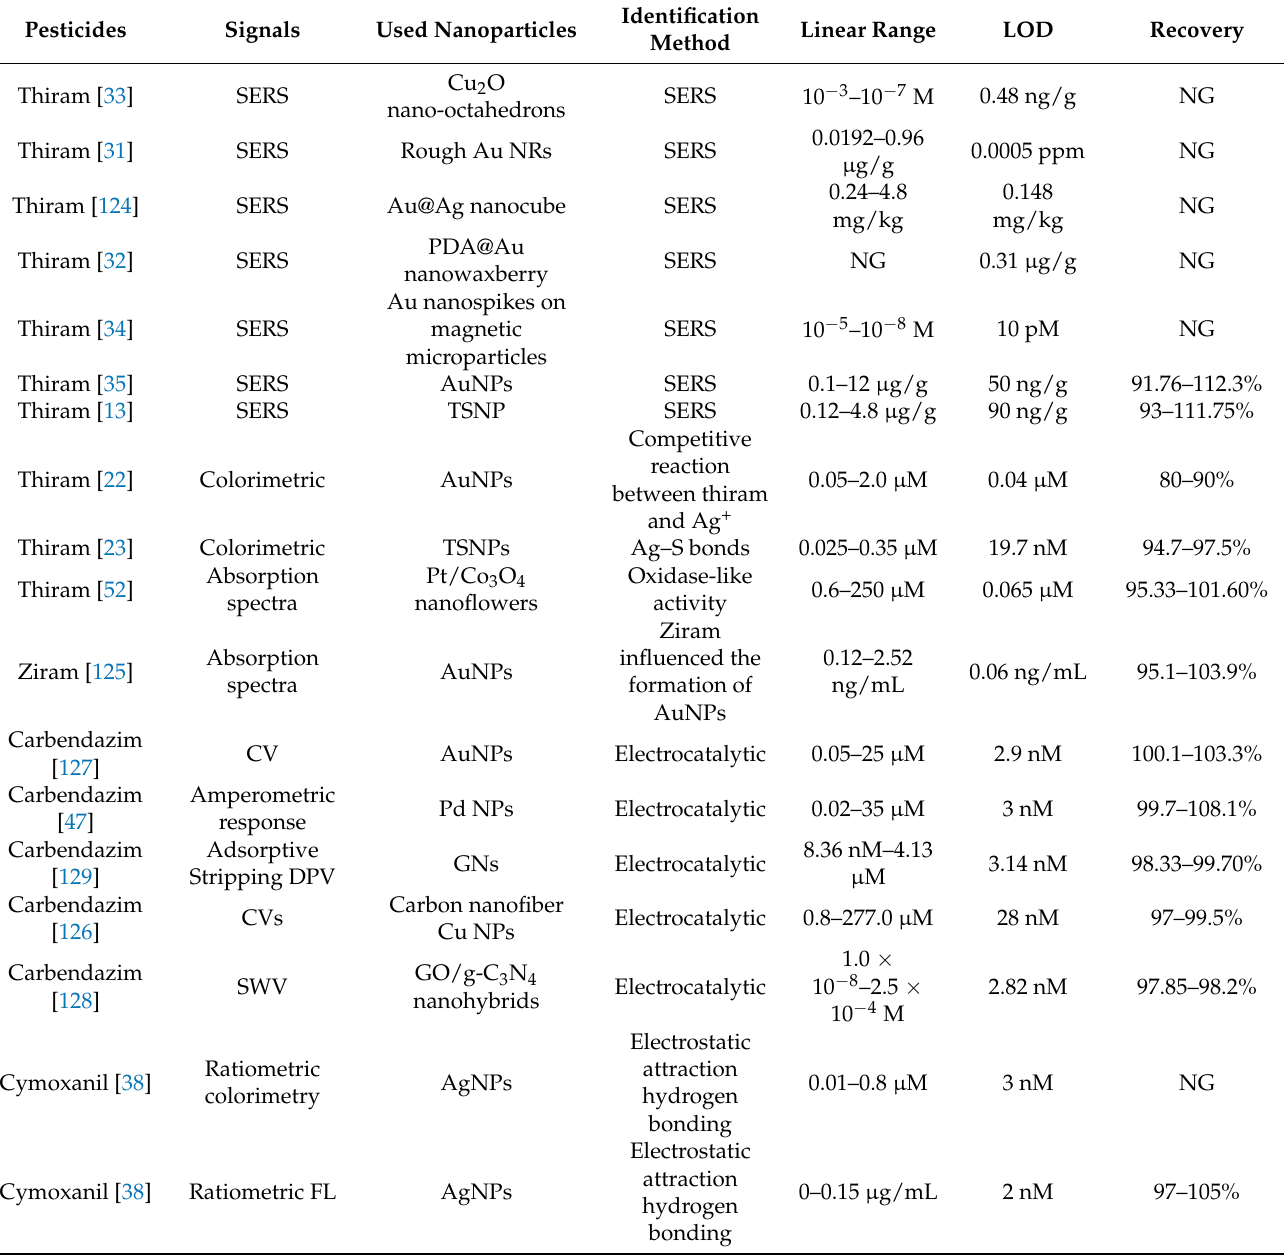
Table 3. The methods and their performances for the detection of